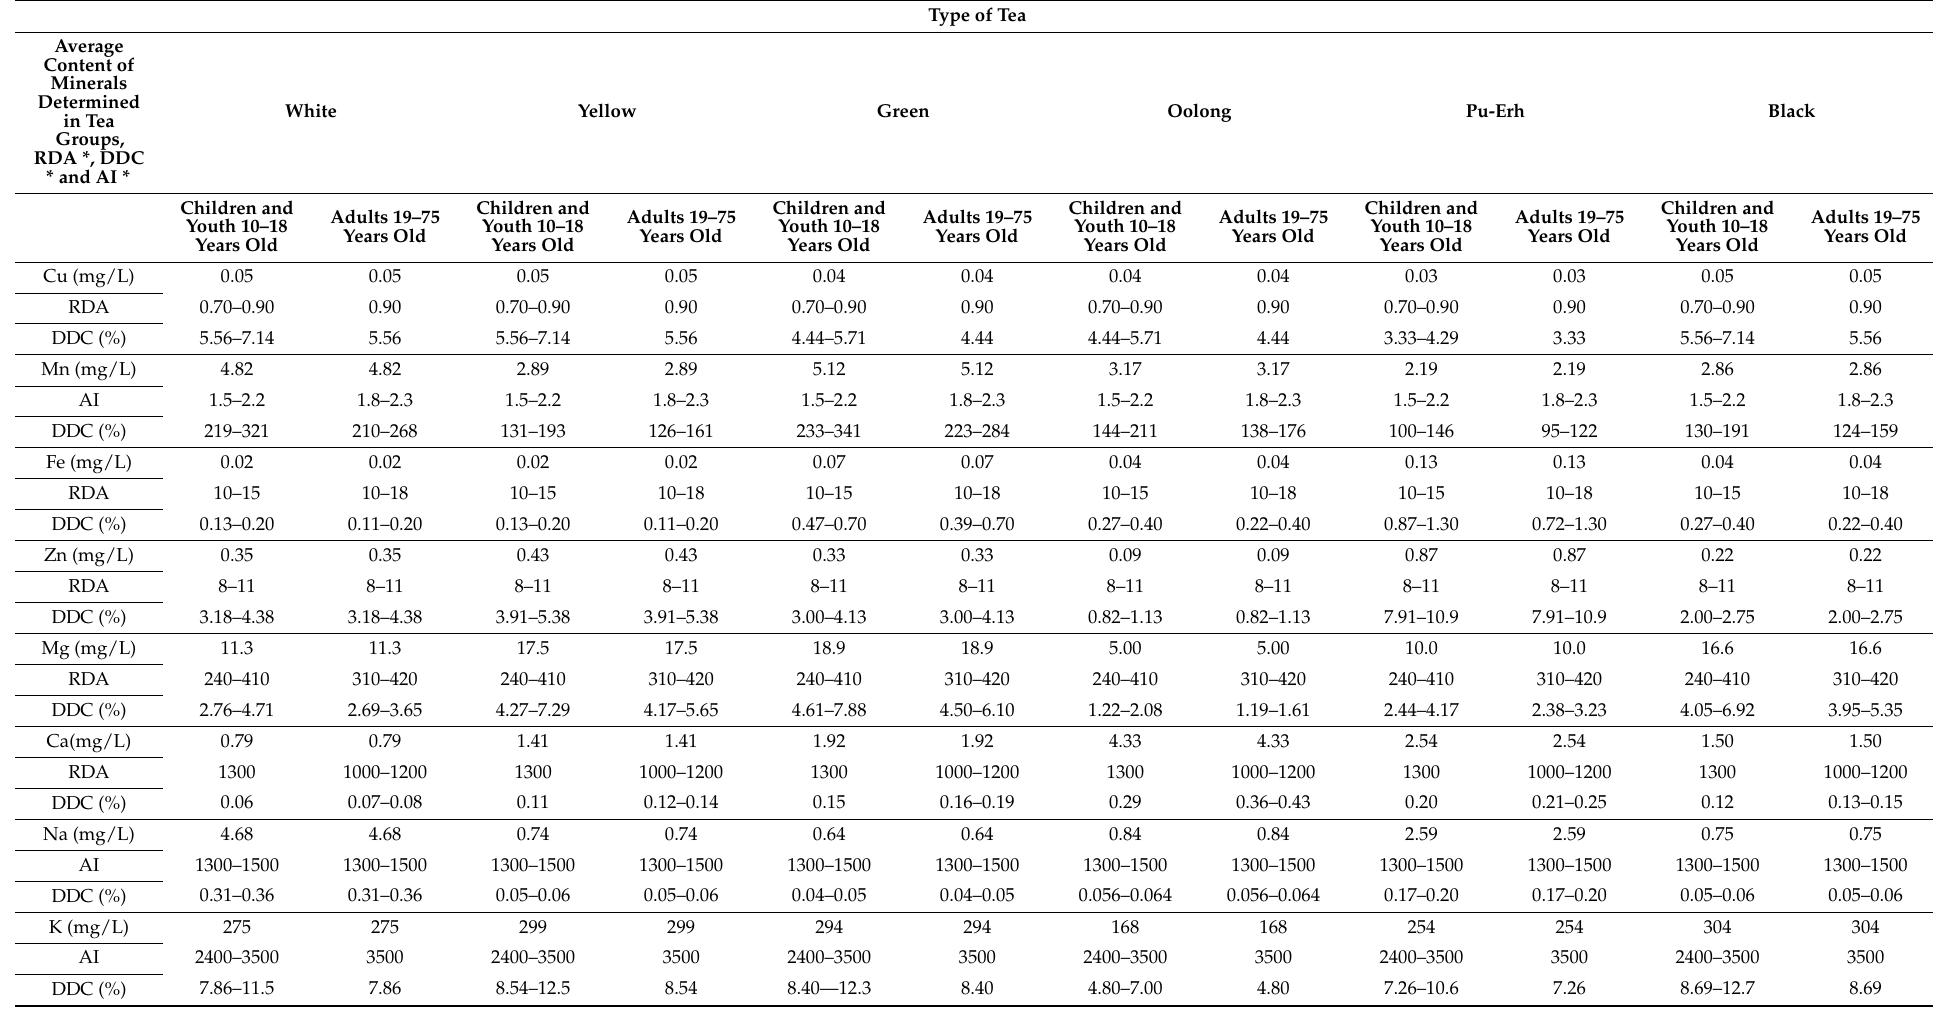
Table 4. Coverage of the demand for selected minerals after consuming 1 L (1000 mL) of tea